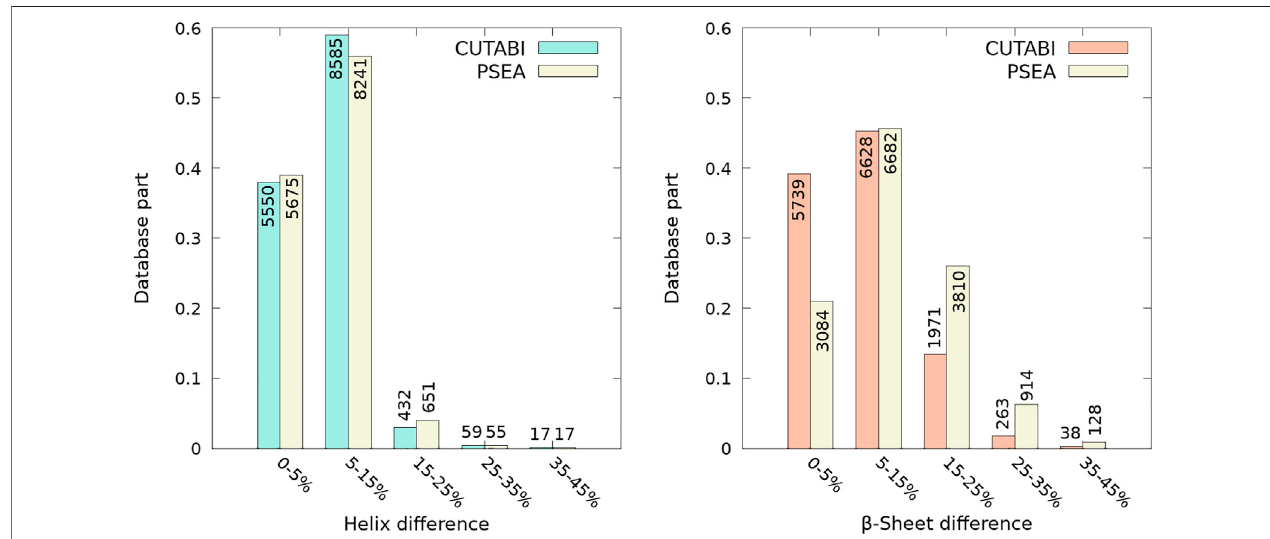
FIGURE 2 | Comparison between the identi fi cation of residues pertaining to the helix and to β -sheet between the all-atom DSSP algorithm and coarse-grained CUTABI and P-SEA algorithms. Each bar of the histograms represents the number of structures of the ASTRAL database as a function of a range of percentages of the difference between CUTABI (green and orange) and DSSP and between P-SEA (yellow) and DSSP. For each protein, the percentage is calculated as the number of residues having a different secondary structure in the coarse-grained algorithms and DSSP, divided by the protein sequence length.